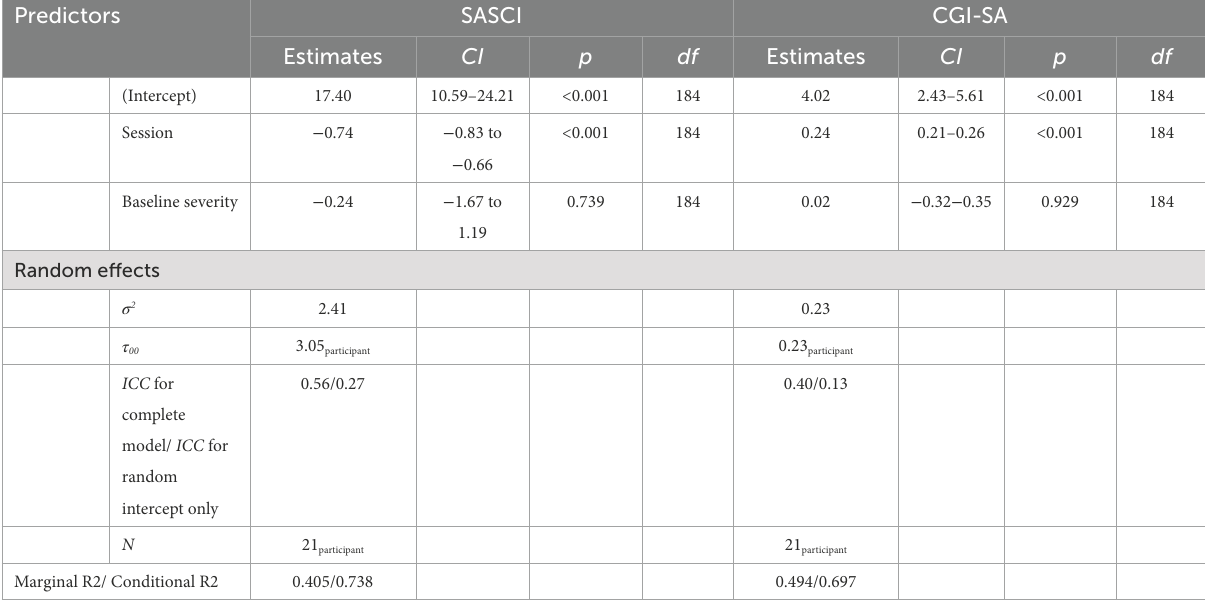
TABLE 1 Linear mixed model for session as fixed-effect explaining self and therapist-reported symptom change while adjusting for baseline severity.